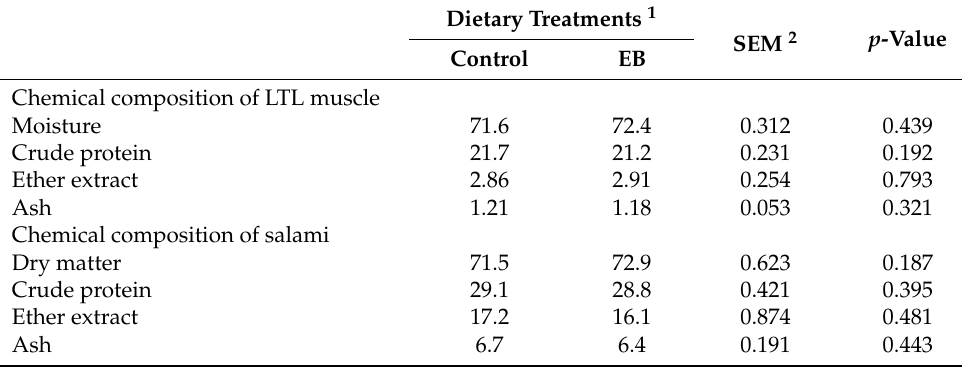
Table 3. Chemical composition of longissimus thoracis et lumborum muscle and salami (g/100 g wet weight).